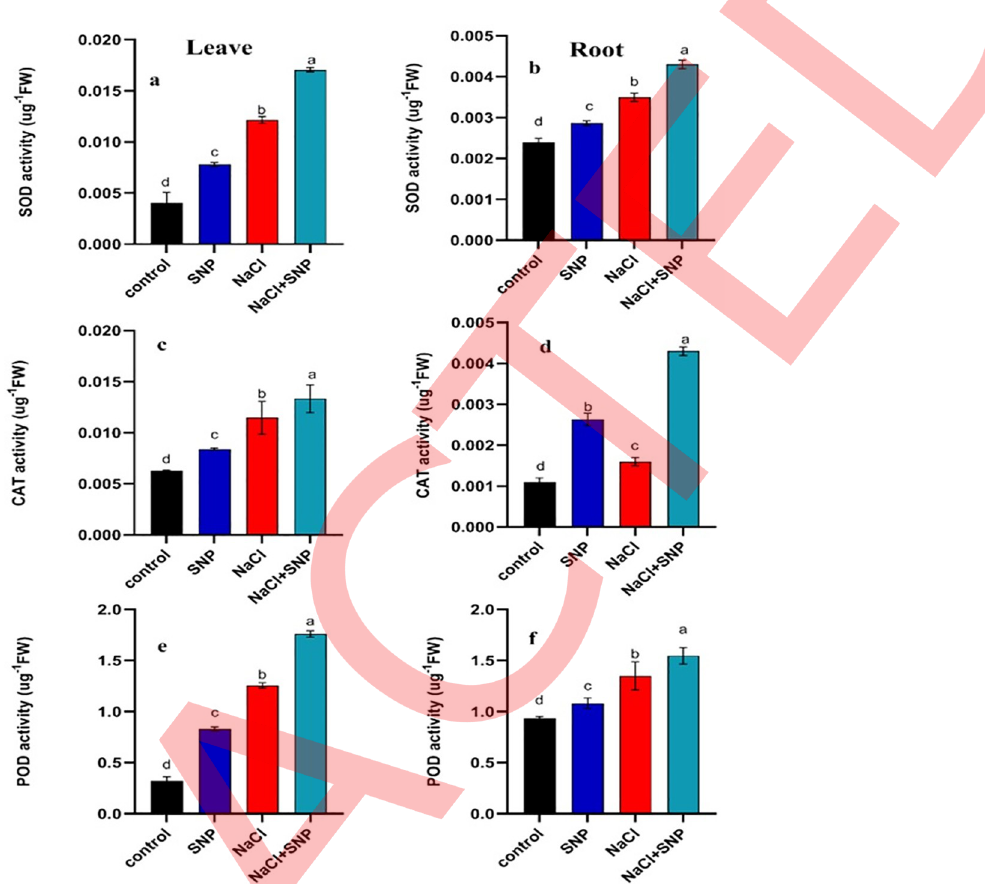
Fig 2. Activities of SOD, CAT and POD content in leaves (a, c, e) and roots (b, d, f) of treated and control soybean plant. Data are means ± SD calculated from three replicates.